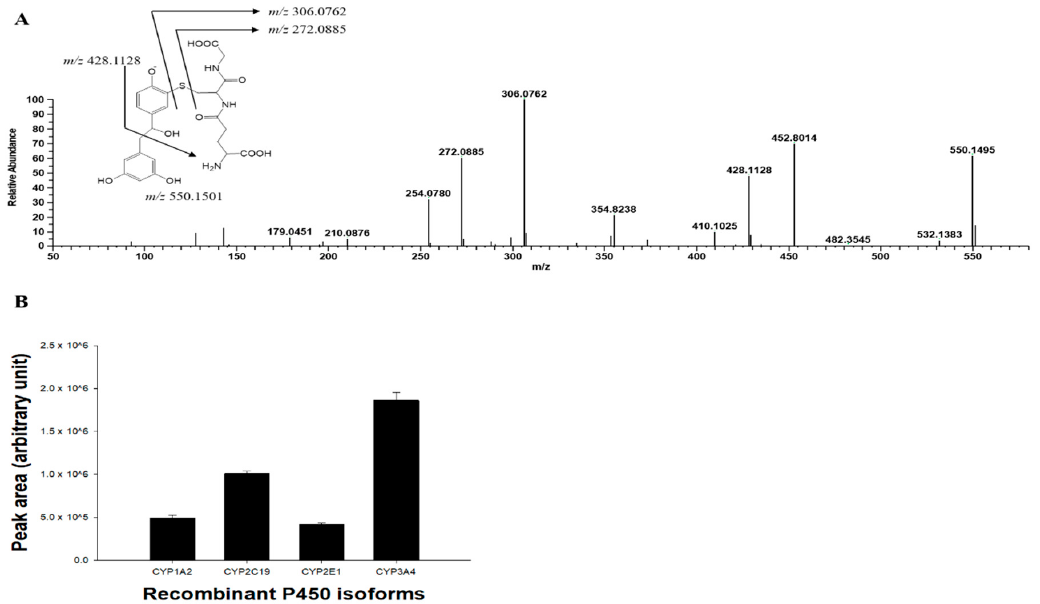
Figure 5. MS/MS spectrum of glutathione conjugate of resveratrol annotated with the proposed structure of fragment ions obtained by LC-HRMS analysis of the human recombinant CYP3A4 incubates of resveratrol in the presence of an NADPH- generating system and glutathione ( A ) and representative plots for the formation of the glutathione conjugate of trans -resveratrol by human recombinant P450 supersome (rP450) ( B ). The incubation system contained 0.1 M phosphate buffer, 1 pmol P450 supersomes, 20 μ M trans -resveratrol, 1 mM NADPH, and 10 mM glutathione. The data are shown as mean ± S.D. ( n = 3).